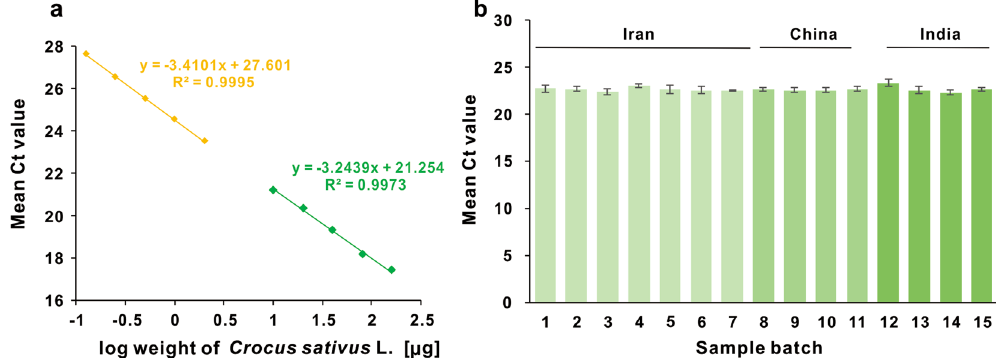
Figure 2. ( a ) Regression curves generated by known amount of Crocus sativus . Two regression curves from top to bottom: the DNA was extracted by commercially available direct plant DNA extraction solution (yellow), silica-based spin column DNA isolation kit (green). ( b ) Ct values of saffron samples from fifteen different batch numbers.